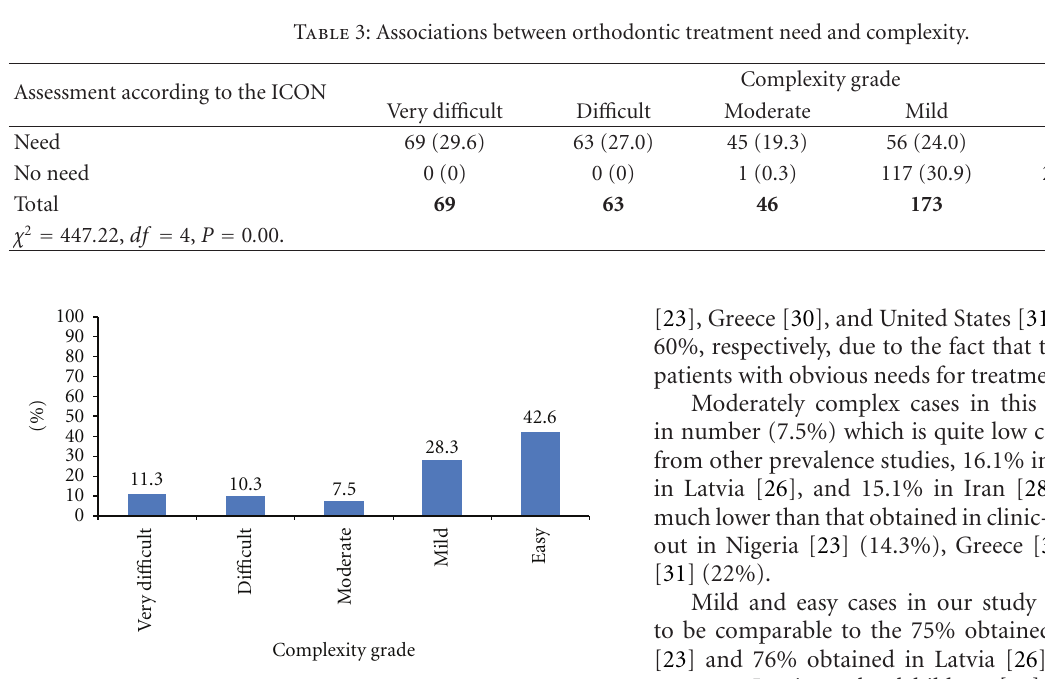
Figure 1: Complexity grades according to the Index of Complexity, Outcome, and